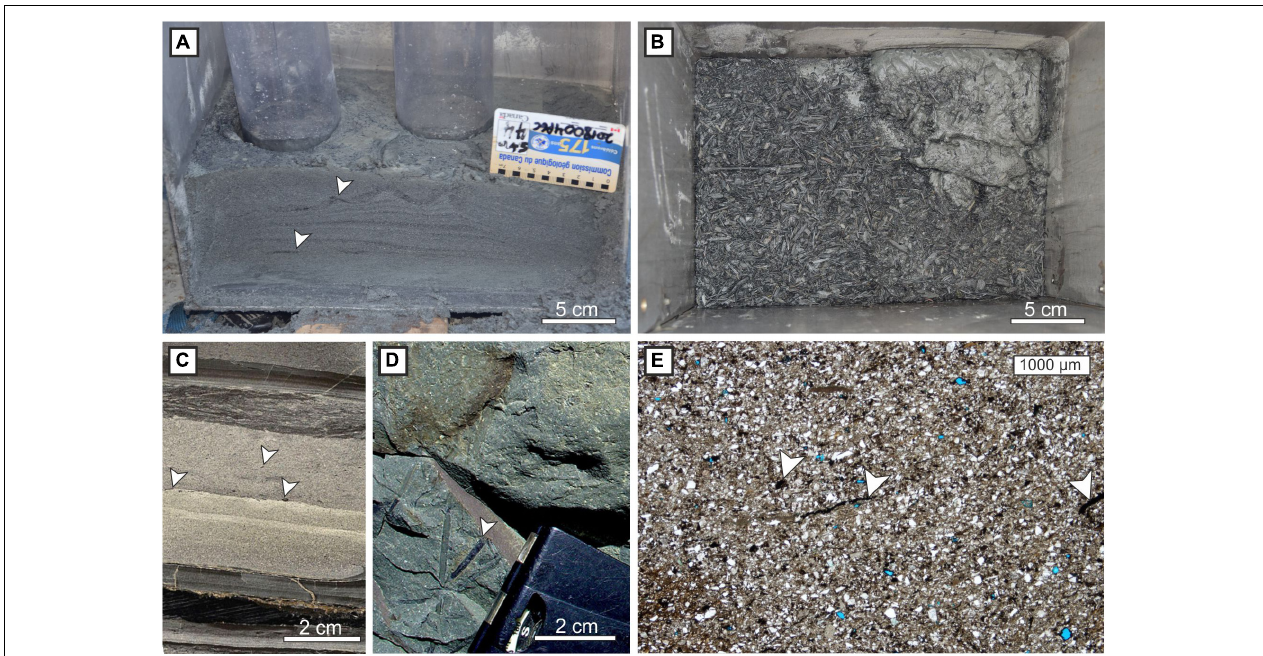
FIGURE 7 | (A) Organic-rich material incorporated within turbidite laminae, and (B) concentrated on the bed top; both from Bute Inlet, British Columbia (courtesy of Maarten Heijnen). (C) Organic material distributed within a hybrid bed and in the uppermost dark-colored division (cored interval, Palaeogene, Gulf of Mexico; Kane and Pontén, 2012). (D) Plant fragments in the upper part of a hybrid bed (Permian, Tanqua Karoo; Hodgson, 2009). (E) Thin-section photomicrograph showing small plant fragments within a hybrid bed (Permian, Tanqua Karoo; Kane et al., 2017). Microplastic fragments and fibers might be anticipated to have similar distributions in deep-water